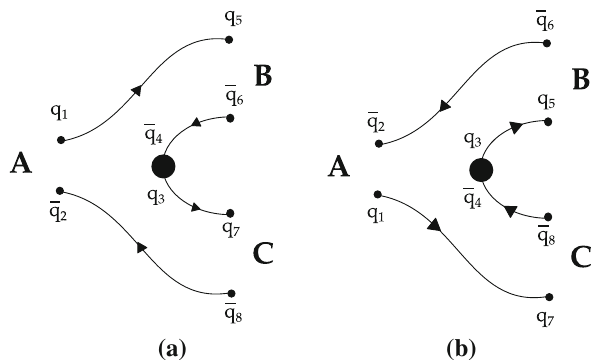
Fig. 1 Diagrams contributing to the A → BC decay process. q i , with i = 1 ,..., 4, and ¯ q j , with j = 5 ,..., 8, are the quarks and antiquarks in the initial and final states, respectively. Picture from Ref. [56]. APS